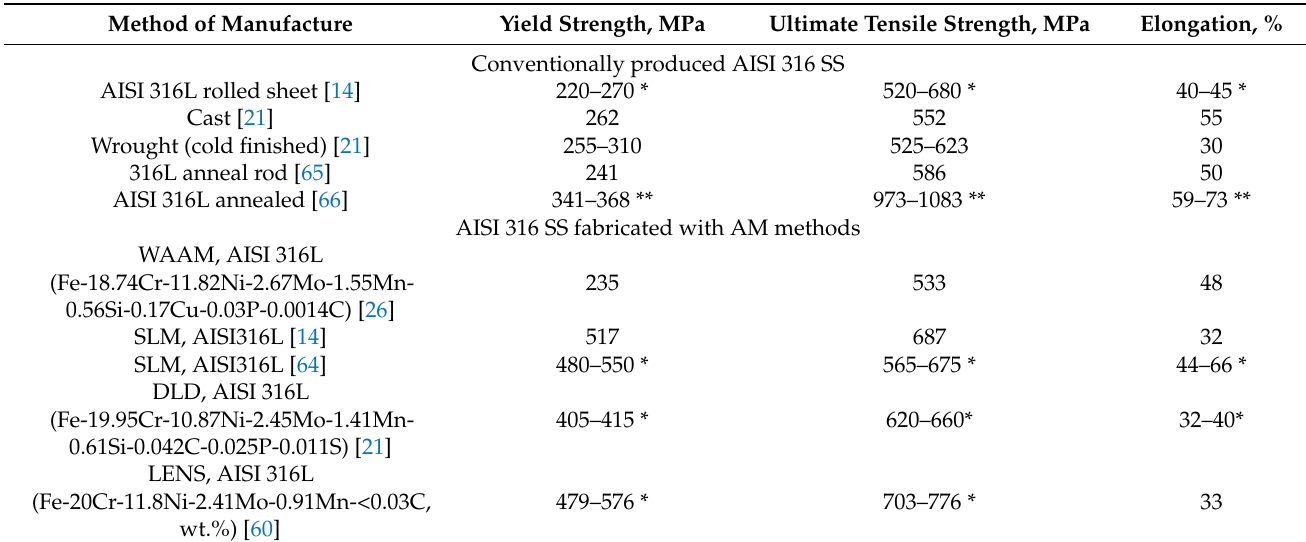
Table 4. Comparison of mechanical properties of some AM AISI 316L stainless steels. The compositions are given in wt.%. Data are adapted from